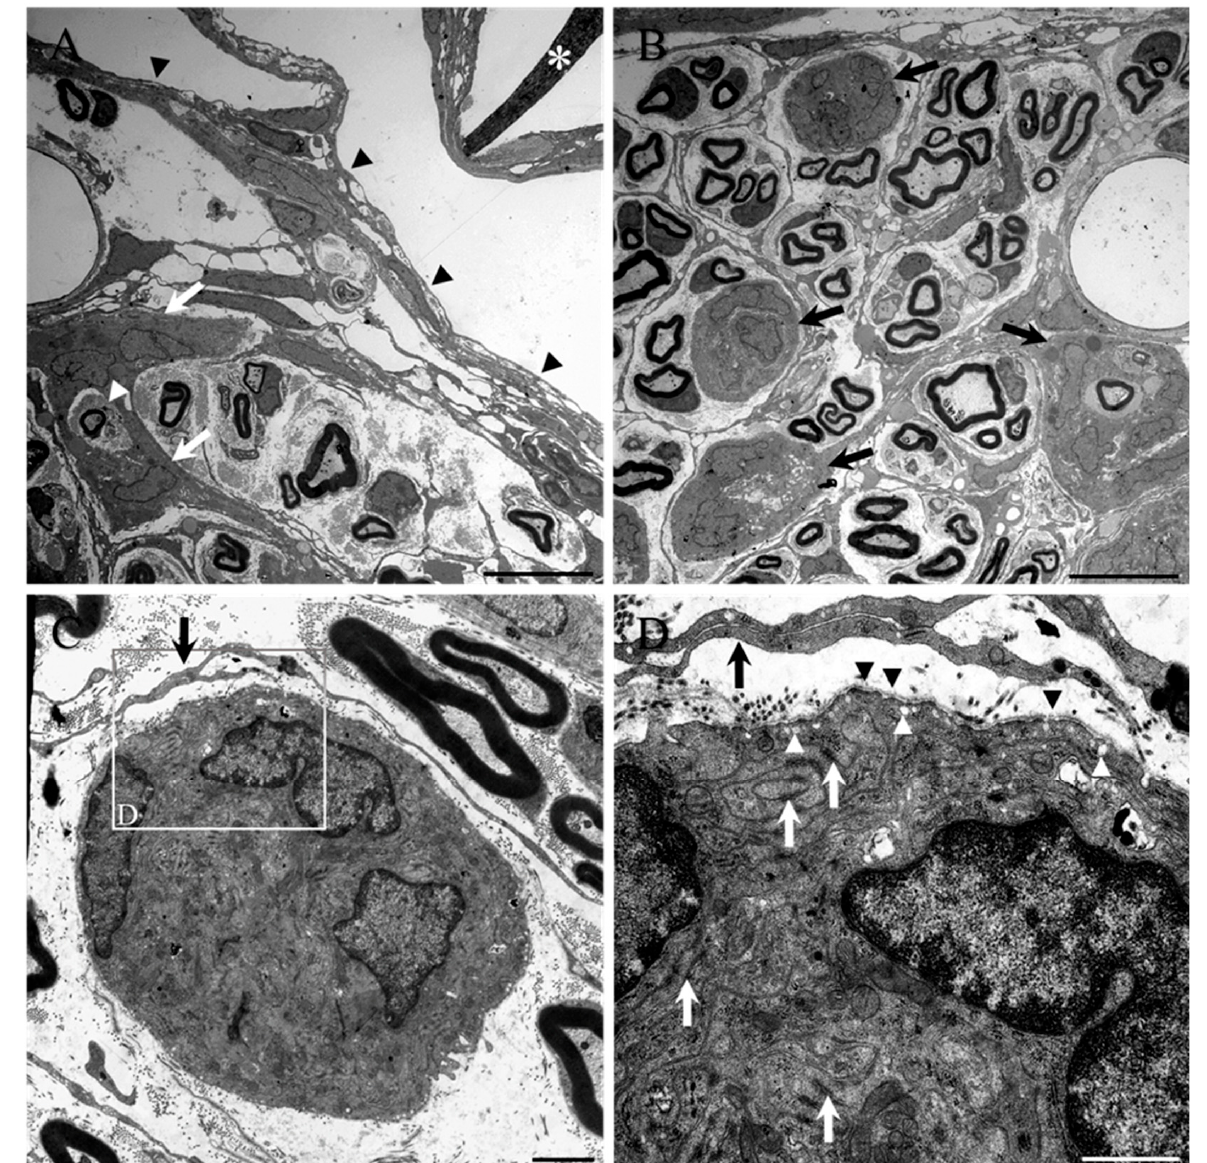
Figure 5. Ultrastructure of the inter-fascicular septae and cell clusters in damaged spinal nerve roots of the collagen scaffold-implanted group . ( A ) Transmission electron microscopy demonstrated the reactive perineurial septae (e.g., white arrows) of a damaged/regenerated spinal nerve root that is close to the implanted collagen scaffold (asterisk). The perineurial surface of the nerve root is indicated by black arrowheads. This particular septum can be seen partially surrounding a loosely packed group of Schwann cell-myelinated axons as well as a single, isolated axon (white arrowhead). ( B ) The reactive PNLC also form rounded clusters or nests of cells (black arrows) that can even form part of the regenerated mini-fascicles and are loosely encircled by the fine processes of fibroblast-like cells. ( C ) Higher magnification of a cell cluster containing 3 PNLC nuclei. ( D ) High magnification of boxed area in ( C ). Many electron-dense, tight junctions can be seen between the intricately interwoven and overlapping processes of the reactive cells (white arrows), and numerous pinocytic caveolae (white arrowheads) are also evident. A discontinuous basal lamina (black arrowheads) is also present over the surface of the cluster. These ultrastructural features were all strikingly similar to those of perineurial cells. The fine overlapping processes of the fibroblast-like cells that surround the mini-fascicle appear to lack a basal lamina and tight junctions. Scale bars: A , B = 10 µ m; C = 2 µ m; D = 1 µ